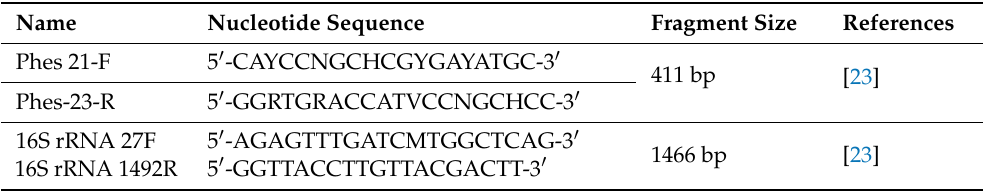
Table 1. Primers used to amplify genes of Lactobacillus